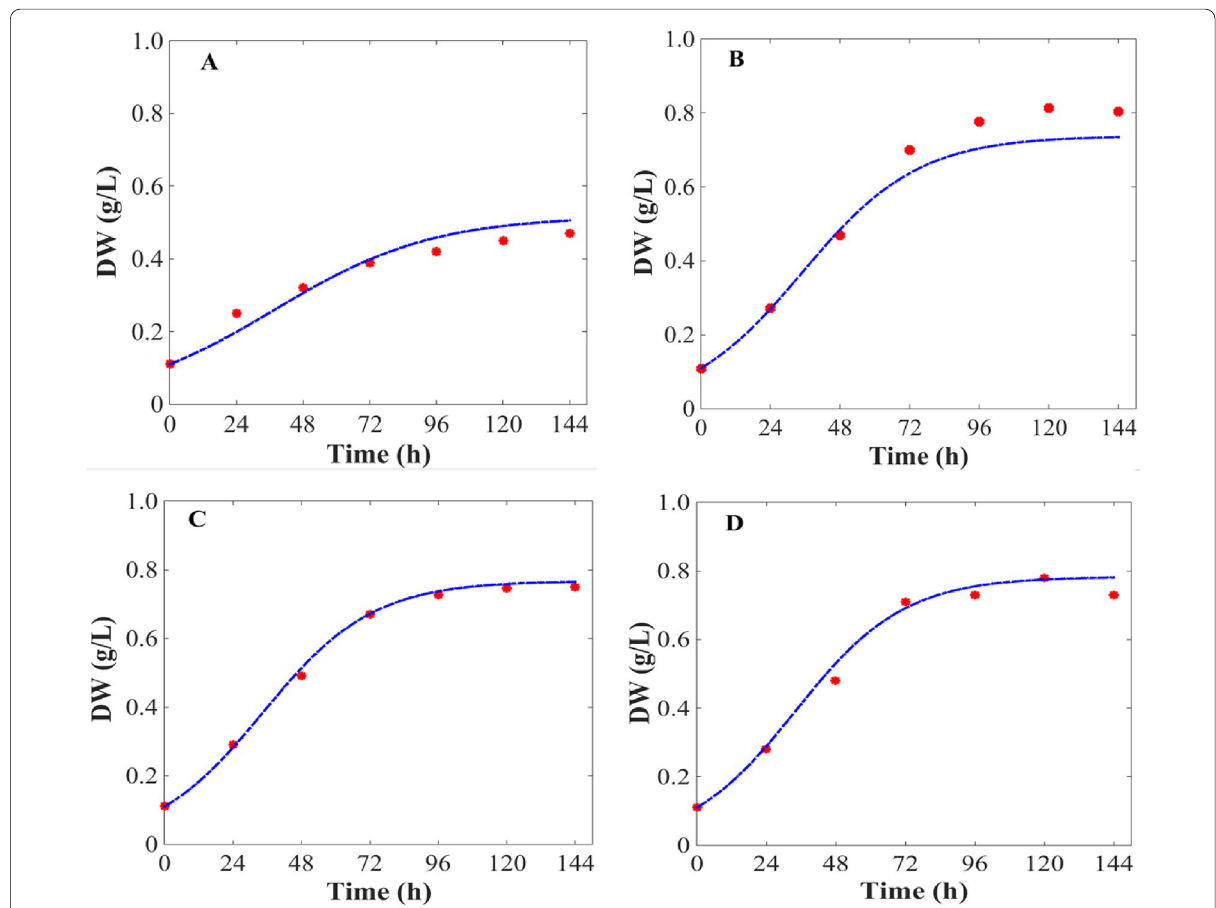
Fig. 5 Comparison of model simulation results and real experimental data of biomass in D. salina . A–D were the arbitrary cultivation condition parameter values showed in Table 3, and the initial DW was 0.1 g was 20, 25, 20, and 25 ℃ , light intensity were 200, 600, 800, and 1000 μmol 200 mM; and the nitrogen concentration was 50, 500, 50, and 500 mg experimental measurements. DW, dry